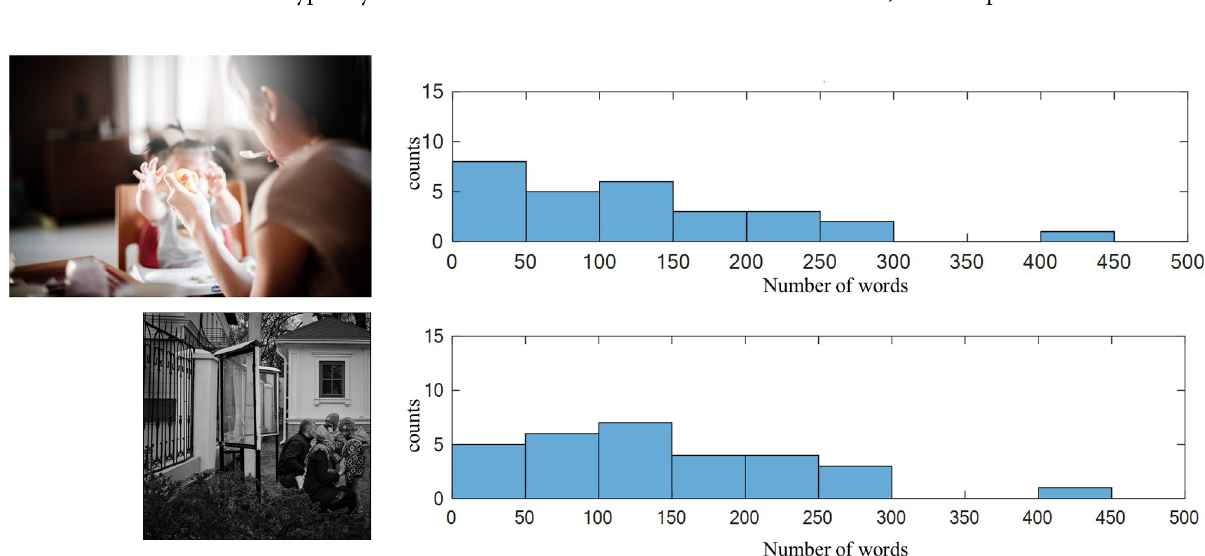
PLOS ONE | https://doi.org/10.1371/journal.pone.0212342 March 27,